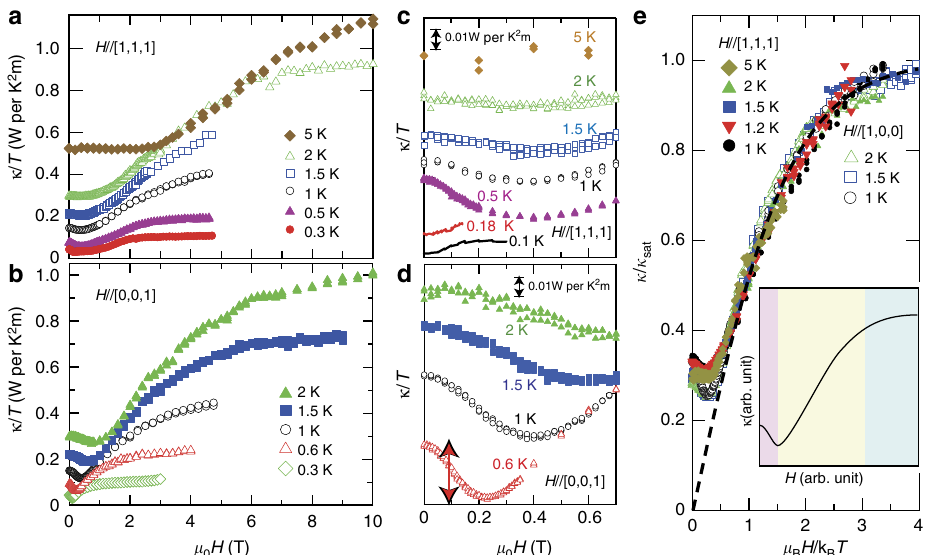
Figure 3 | Heat conduction under magnetic fields. ( a , b ) Field dependence of k / T of Yb 2 Ti 2 O 7 for H || [1, 1, 1] and [0, 0, 1] with the heat current along [1, (cid:3) 1, 0]. ( c , d ) Field dependence of k / T at low field. Data are shifted vertically for clarity. Double-headed red arrow indicates the initial reduction of k ( H )/ T for H || [0, 0, 1] at T ¼ 0.6K, which is estimated to be 0.03W per K 2 m, giving a lower-bound estimate of the monopole contribution. ( e ) Normalized thermal conductivity k / k sat plotted against m B H / k B T , where k sat is the saturated thermal conductivity at high fields. k sat at high temperatures is determined so as to fit the scaling curve. The dashed line represents the Brillouin function with spin ¼ 1/2, assuming g ¼ 0.79. The inset illustrates the typical behaviour of k ( H )/ T . There are three characteristic regimes, low-, intermediate- and high-field regimes, which are indicated by pink, yellow and blue colours, respectively.